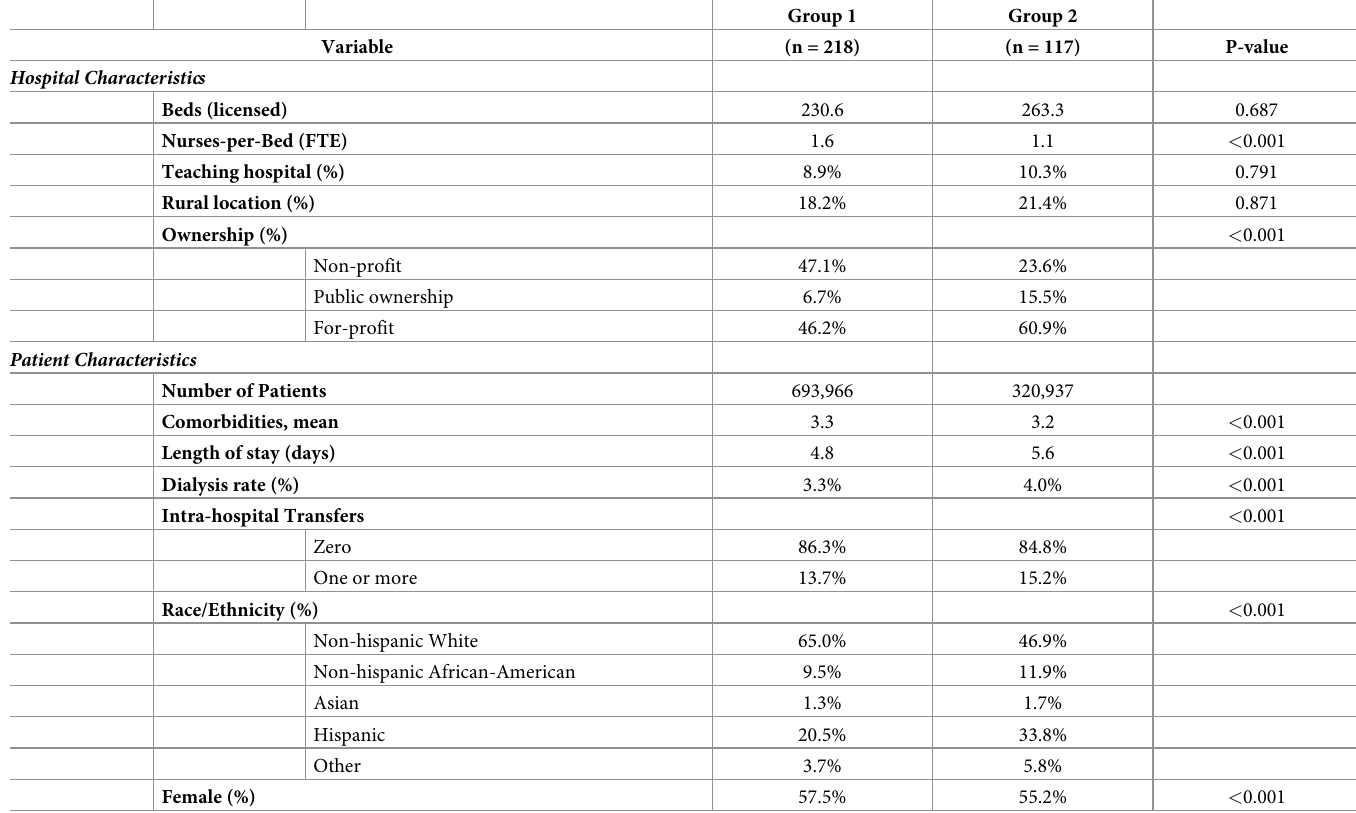
Table 2. Comparison of Group 1 (private room) hospitals and Group 2 (bay room) hospitals.